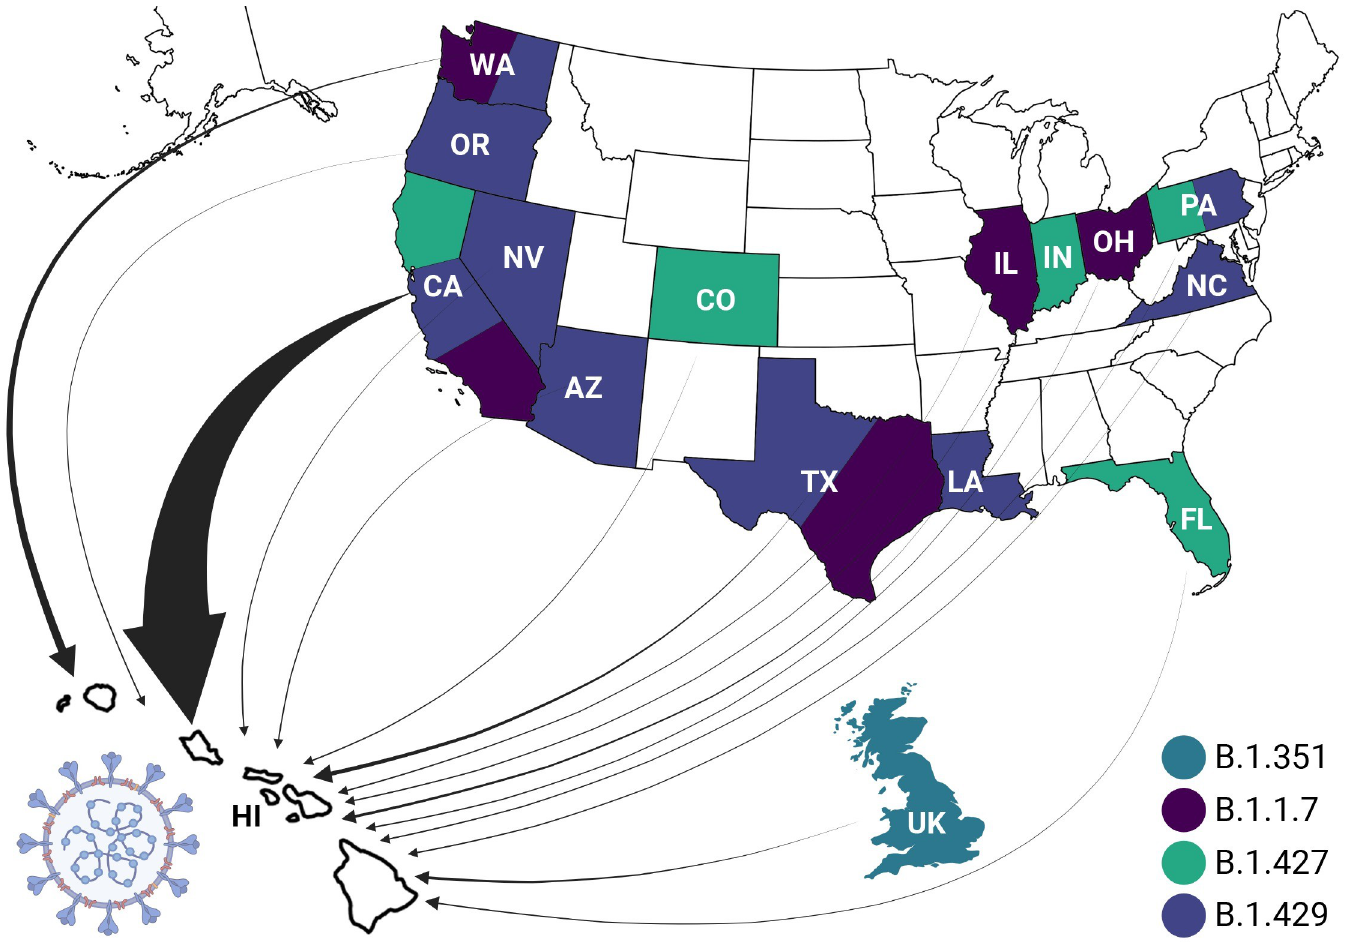
Fig 3. Introduction of the SAR-CoV-2 variants of concern in Hawai’i. This figure shows the states within the United States, and countries worldwide, from which the SARS-CoV-2 variants of concern (VOC) have been introduced into Hawai’i. Represented geographical locations are: California (CA), Washington (WA), Texas (TX), Louisiana (LA), the United Kingdom (UK), Pennsylvania (PA), Colorado (CO), Florida (FL), Arizona (AZ), Illinois (IL), Indiana (IN), Nevada (NV), North Carolina (NC), Ohio (OH) and Oregon (OR). Blue represents the origin of B.1.351 VOC, yellow represents the origin of B.1.1.7 VOC, pink represents the origin of B.1.427 VOC, and the green represents the origin of B.1.429 VOC. The width of the arrows is proportional to the abundance of introductions of VOC from various geographic areas. Maps generated with the open-source “usmap” and“ggplot2” packages and R under GPL-3 and MIT+ license and are free to use